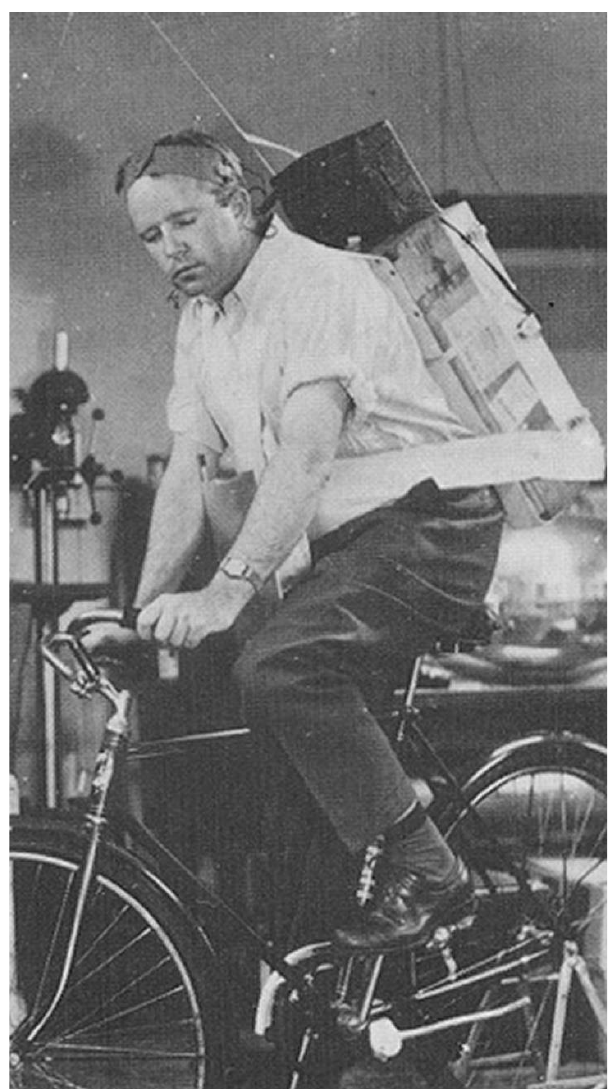
Figure 4 : Norman Jefferis Holter with his original 38-Kg electrocardiogram recording backpack device